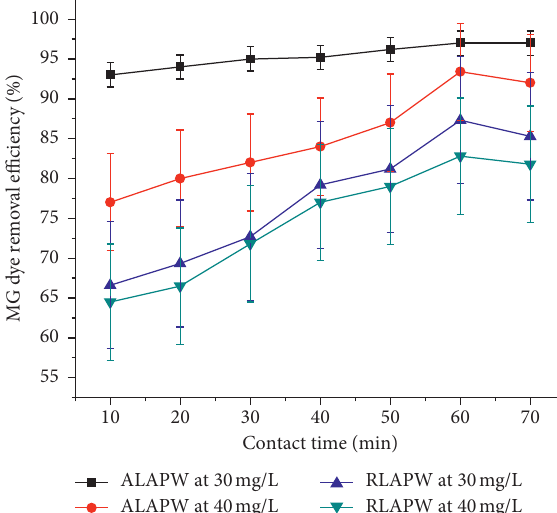
Figure 7: Contact time effect on MG dye removal by ALAPW and RLAPW at adsorbent dose 0.2g, pH 4 (ALAPW) and pH 6 (RLAPW), initial MG dye concentration 30 and 40 mg/L, and temperature (298 K) with agitation speed 200rpm.